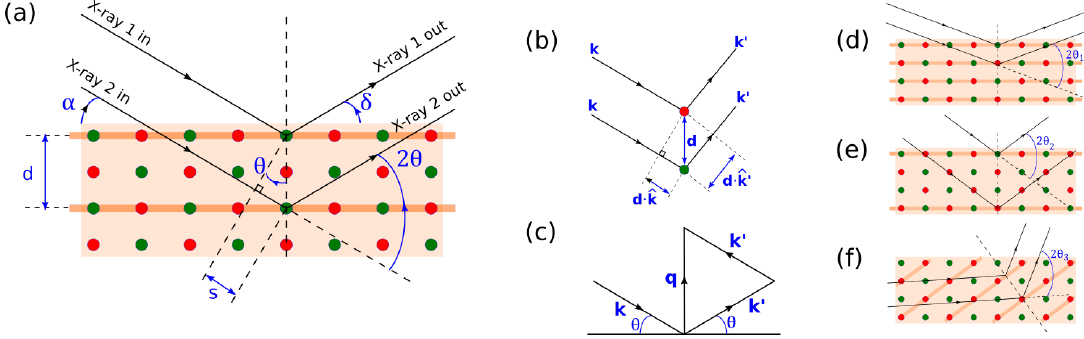
Figure 2. ( a ) Condition for constructive interference in XRD. Red and blue circles represents scattering centers for X-rays. α is X-ray incidence angle, δ is X-ray exit angle. d is the separation between Bragg (reflecting) planes, and s is half the path difference between two rays. θ is the Bragg angle. Bragg planes are indicated by thick orange lines. ( b ) Generalized vectorial description of subfigure (a). ( c ) Vectorial description of the condition governing constructive interference; Changing θ leads to a different set of Bragg planes with different d ( d , e ). Changing an X-ray wavelength will also change θ in a similar way. On the other hand, changing incidence/exit angle allows us to sample Bragg planes that are not parallel to the sample surface ( f